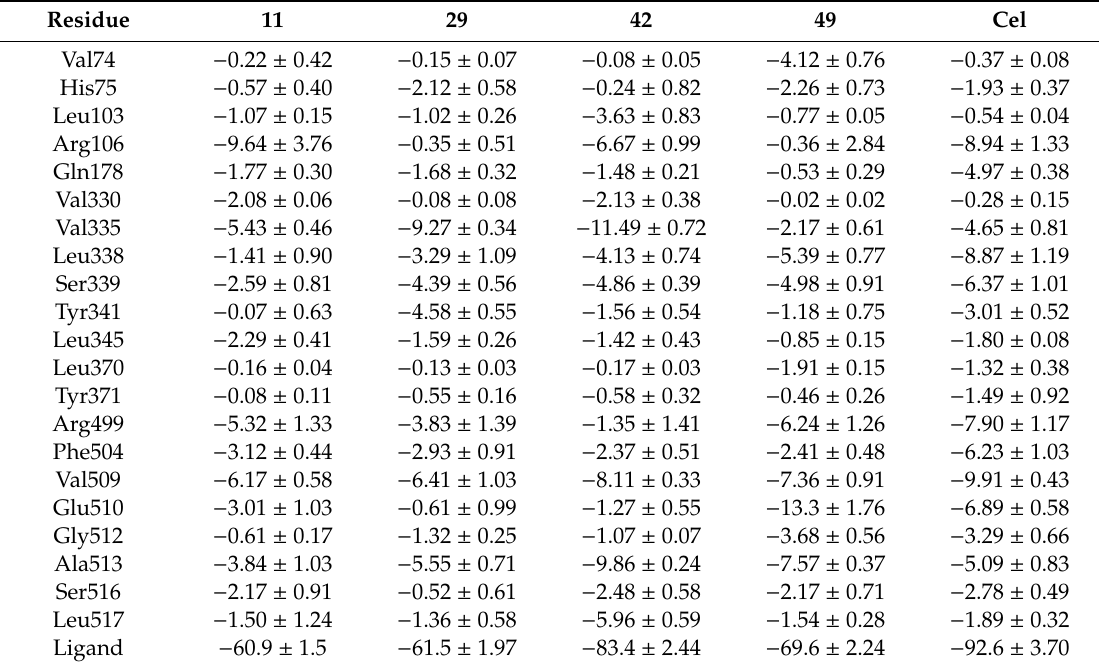
Table 4. Molecular mechanic / Poisson Boltzmann surface area (MM / PBSA) per-residue decomposition energies for selected residues of those complexes between COX-2 and 11 , 29 , 42 , 49 , and celecoxib using the last 40-ns molecular dynamics (MD)